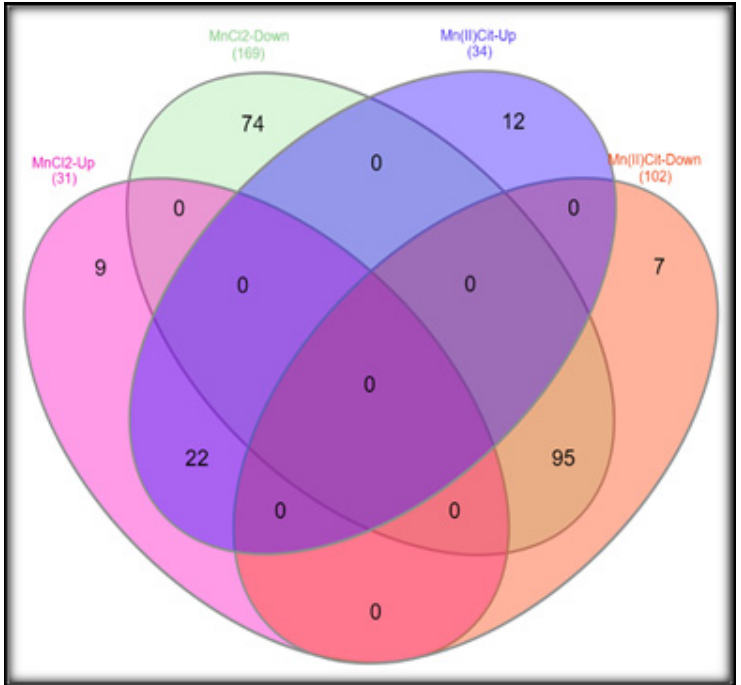
Figure 2. Three microarray assays in SH-SY5Y after exposure to MnCl 2 or Mn(II)Cit (0–500 µM) for 24 h yielded overlapping results of 117 genes differentially expressed and affected by both chemical species of Mn. Significant differences were estimated through two-way ANOVA, followed by false discovery rate and Bonferroni ( p <